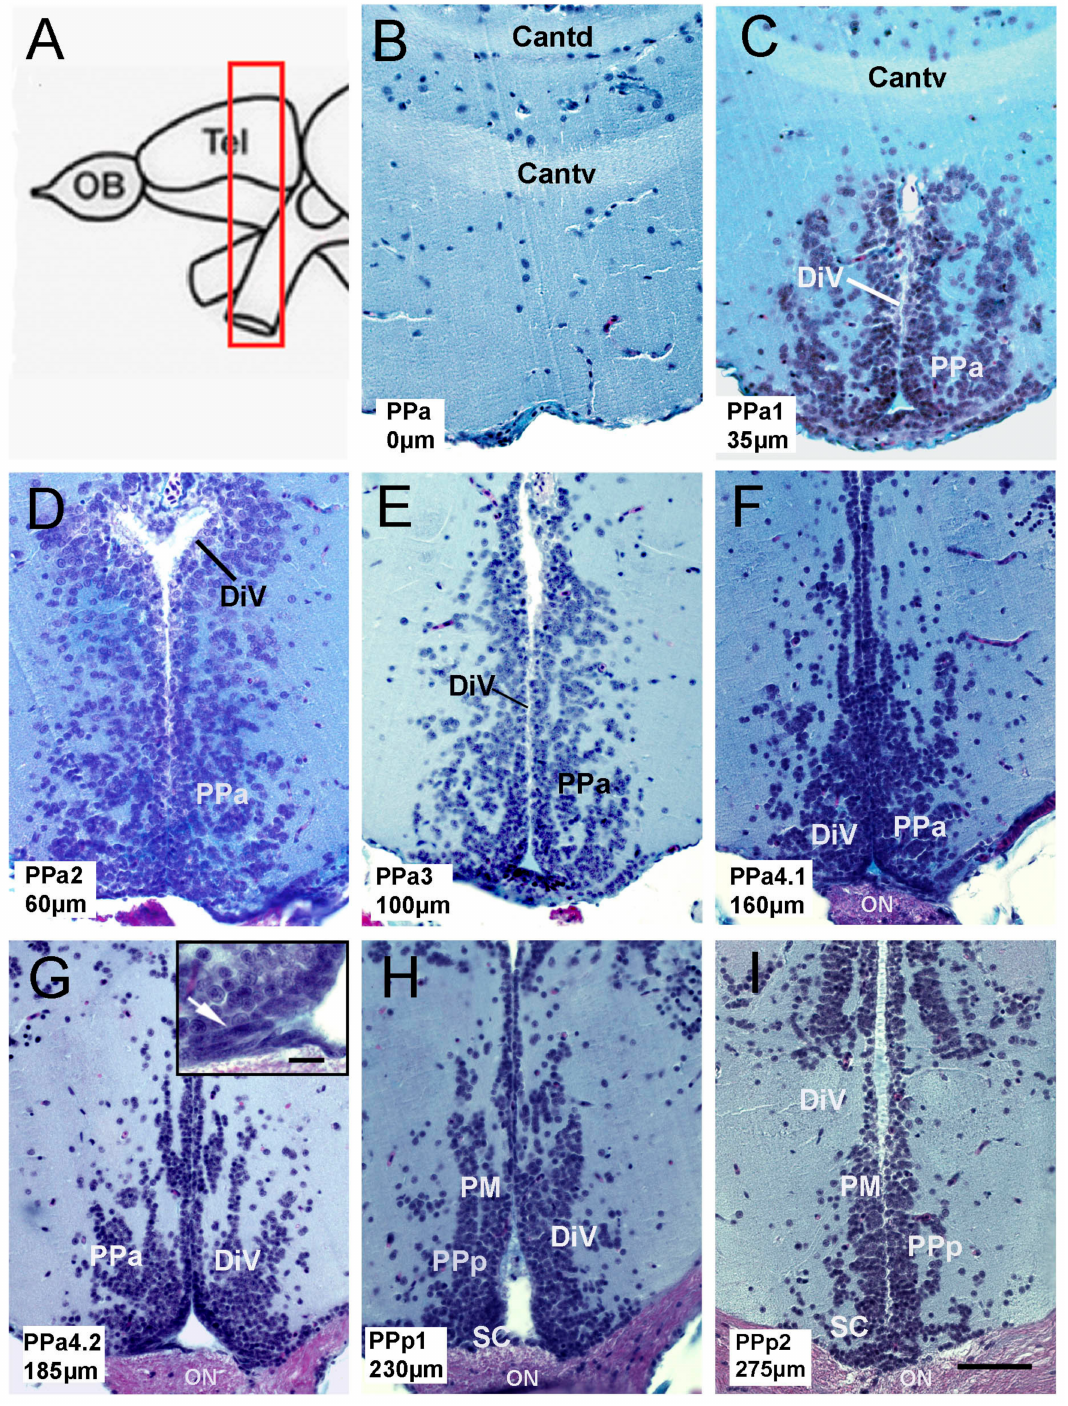
Figure 1. Anatomy of the preoptic area (POA) in adult zebrafish. ( A ) Schematic representation of zebrafish brain. The red, boxed area indicates the POA region. ( B – I ) Transverse paraffin sections of the POA stained using trichrome stain. POA region starts from the commis-sure anterior to the optic chiasm. Each slice corresponds to the representative region of the POA, categorized with a code: PPa0, PPa1, PPa2, PPa3, PPa4.1, PPa4.2, PPp1, and PPp2, where the numbers indicate the distance in µ m from the beginning of the POA. ( G ) Cells with a fusiform nucleus are observed in the ventral region of the PPa (arrow in the boxed area). Commissure, pars dorsalis (Cantd); anterior commissure, pars ventralis (Cantv); diencephalic ventricle (DiV); anterior part of the parvocellular preoptic nucleus (PPa); posterior part of the parvocellular nucleus (PPp); optic nerve (ON); suprachiasmatic nucleus (SC); magnocellular nucleus (PM). Scale bar: ( I ) 50 µ m, ( G ) in r.ectang.le 10 µ